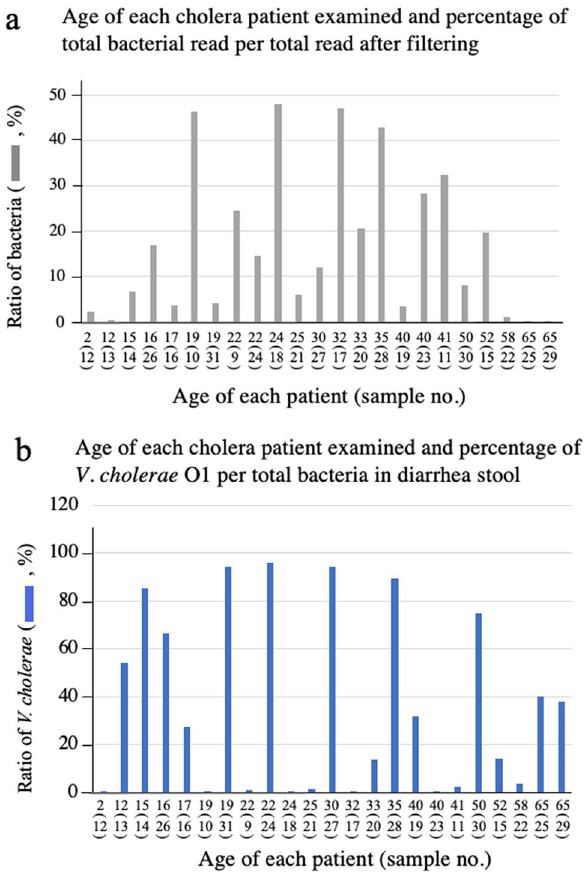
Figure 2. Age of patient and the ratio of the number of read detected by metagenomic sequencing analysis of their stools. The DNA in the stool samples from 23 patients who were diagnosed with cholera disease were extracted using a commercially available kit. Patient ages are listed in Supplementary Table S1. The extracted DNA were investigated by a metagenomic sequencing analysis to clarify the origin of individual DNA. The origin of the DNA sequences was assigned by mapping to a database that included human and microorganism sequences. The obtained numbers of total reads, total bacterial reads, reads originating from V. cholerae , reads originating from ctxA in each sample are shown in Supplementary Table S3 (the data from DNA sample). The age of each patient and the ratio of the number of reads from all bacteria to the total number of reads after filtering ( a ) and the ratio of the number of reads from V. cholerae to the number of reads from all bacteria ( b ) were calculated. The horizontal axis of these figures shows the age of each patient and is the same arrangement in both ( a ) and ( b ). The numbers in parentheses indicate the sample numbers. This sample number is also the patient’s